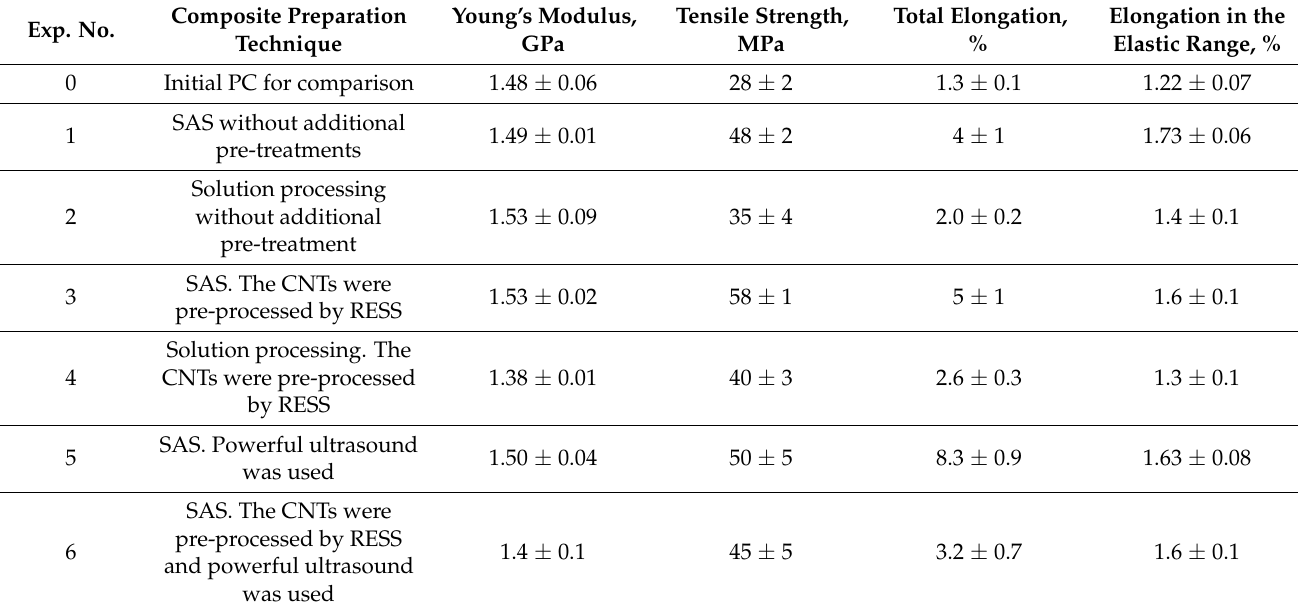
Table 2. Mechanical properties of PC-cylindrical carboxylated CNT composites obtained by different methods. Exp.